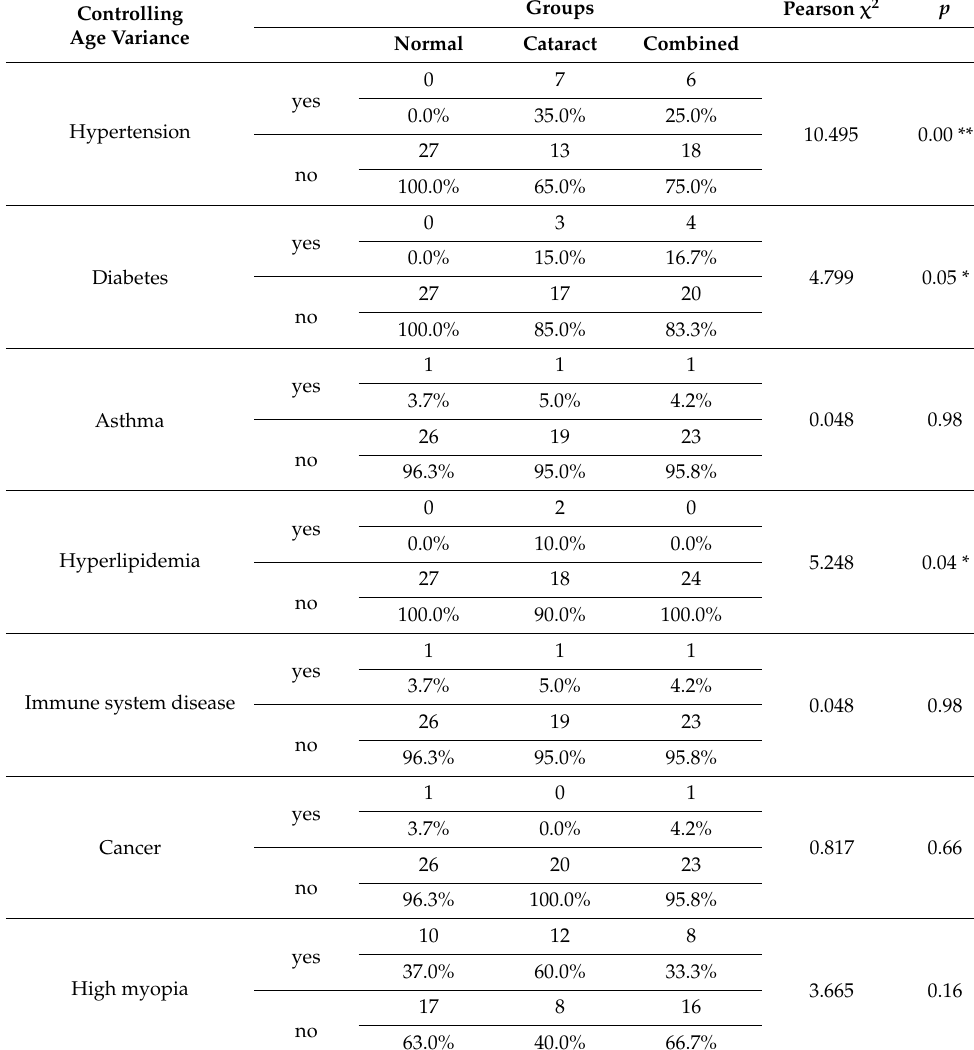
Table 2. Health status analysis using Pearson χ 2 for each group.